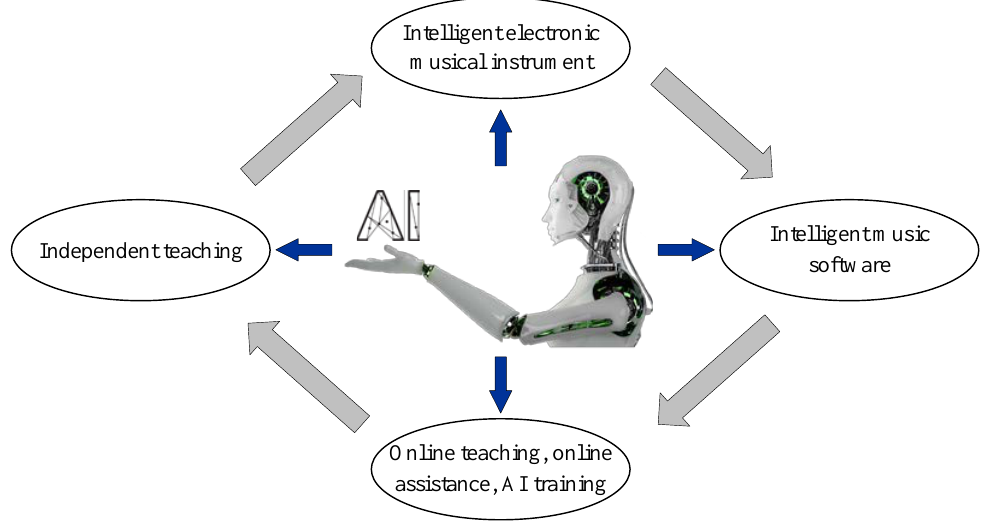
Figure 1. The Relationship between AI and music education.